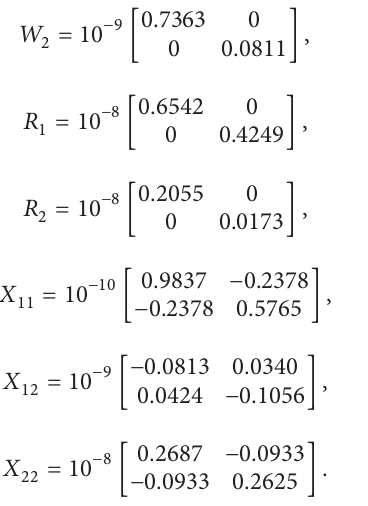
Figure 3: State trajectory of 𝑒 1 (𝑡) and 𝑒 2 (𝑡) of error system